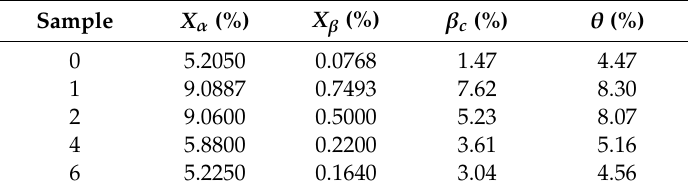
( c ) Figure 9. ( a ) X-ray diffraction (XRD) atlas of pure PP without ultrasound. ( b ) XRD atlas of pure PP with ultrasound. ( c ) The w c,x values of pure PP without ultrasound and with ultrasound. The XRD curves were quite different for the WBG-PP cooled at the different water temperatures, as shown in Figure 10. In Figure 10a and Figure 10c, it can be seen that the diffraction intensities of the α (110), α (040), α (130), and β (300) crystal planes were greatly affected by cooling temperature,